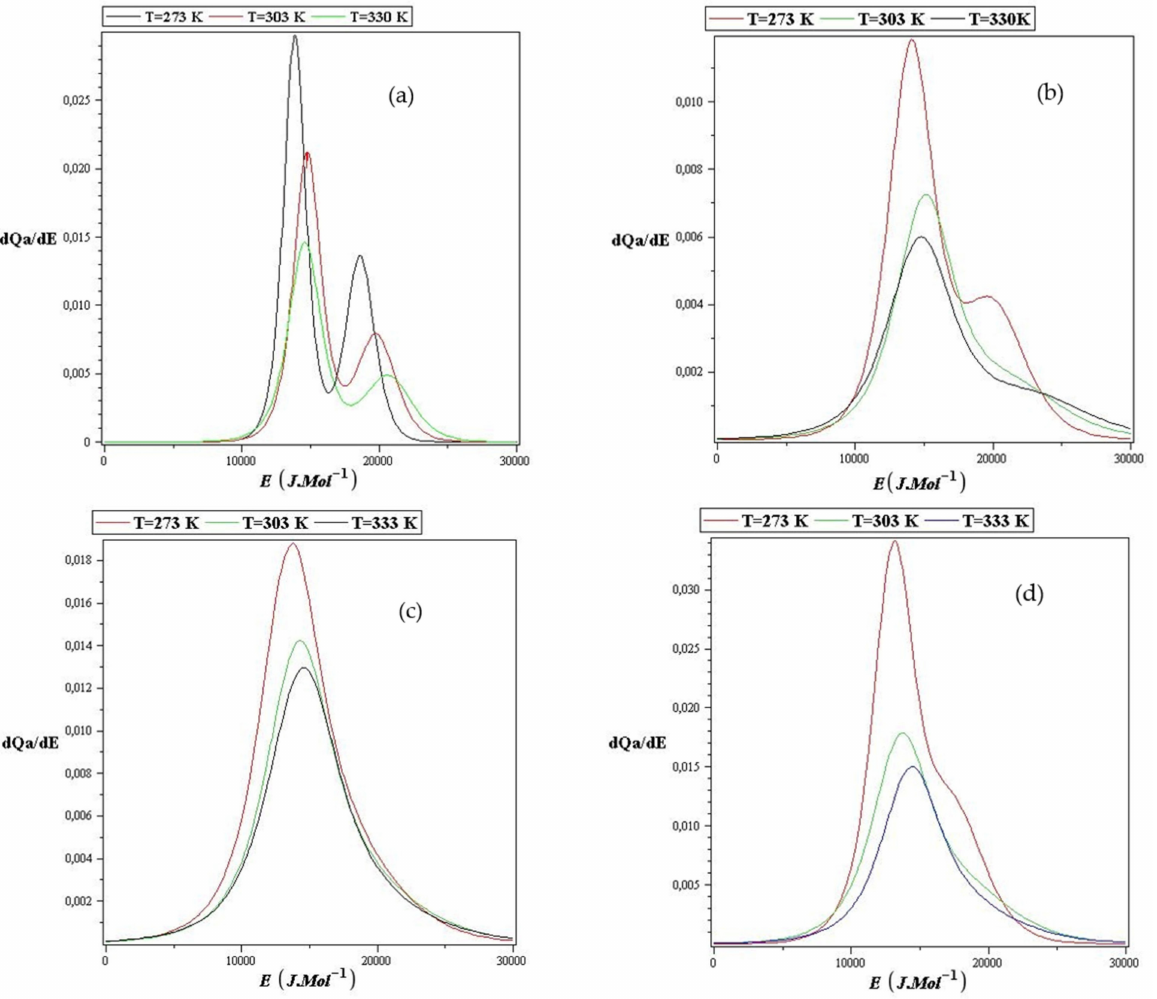
Figure 10. Site energy distributions of CO 2 adsorption onto ( a ) Na-ZSM-5, ( b ) Mg-ZSM-5, ( c ) La- ZSM-5 and ( d ) Zn-ZSM-5 at the three tested